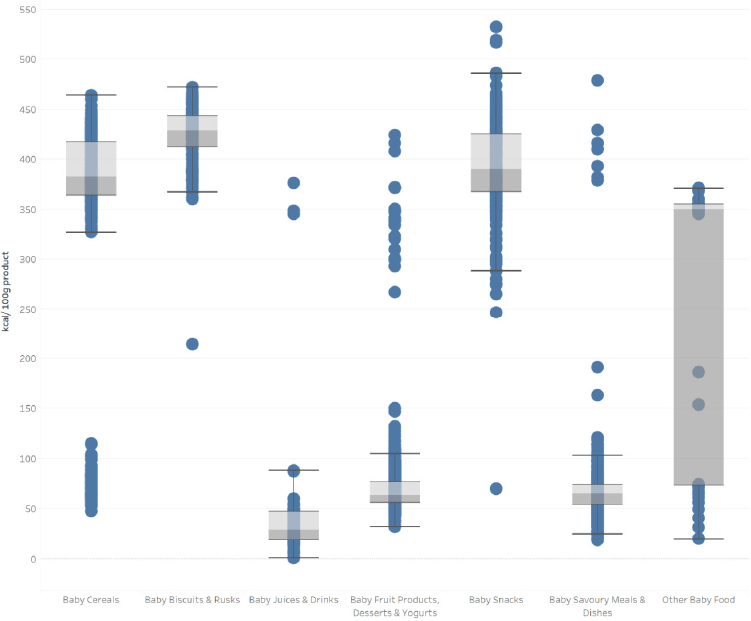
Figure A1. Energy content (kcal/100 g product) by baby food category.